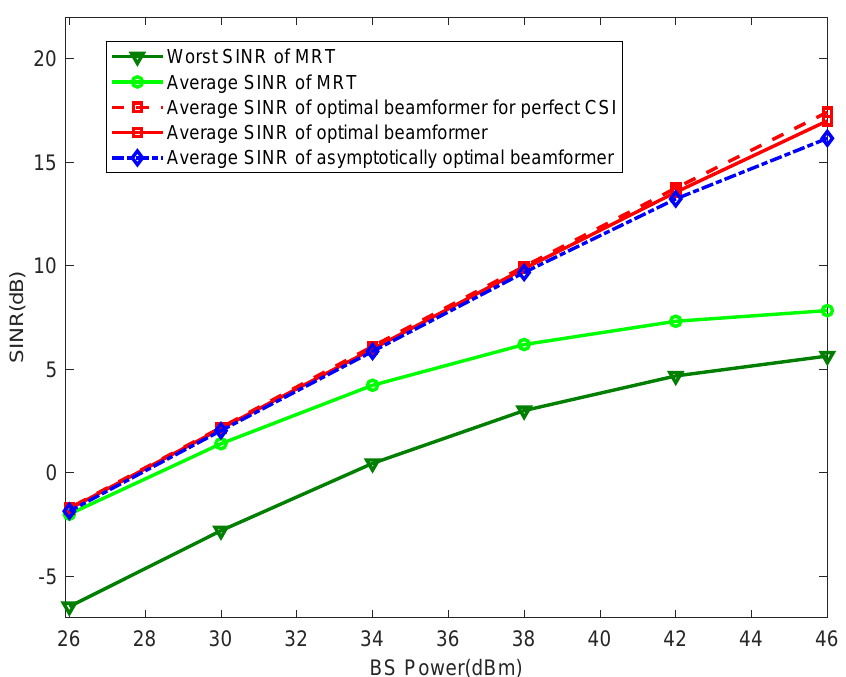
Figure 4. The achieved SINR among several algorithms with regard to P ( M = 64, I = 4, K = 3, r = 0.1, τ =